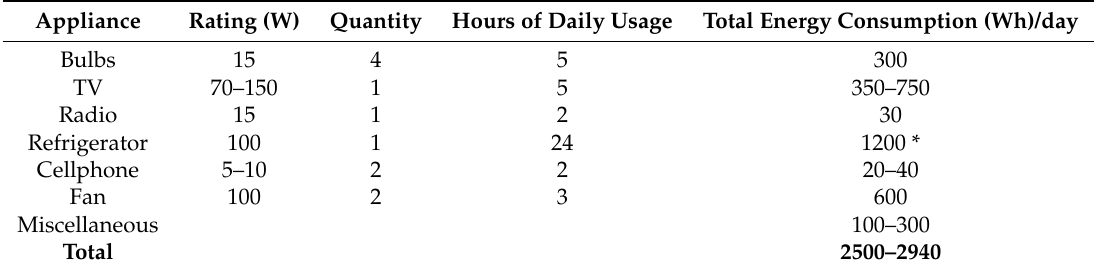
Table 2. Estimated Electricity Demand per